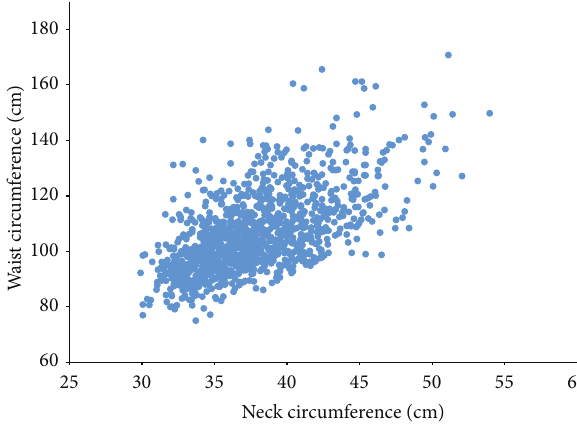
Figure 2: Plot relating waist and neck